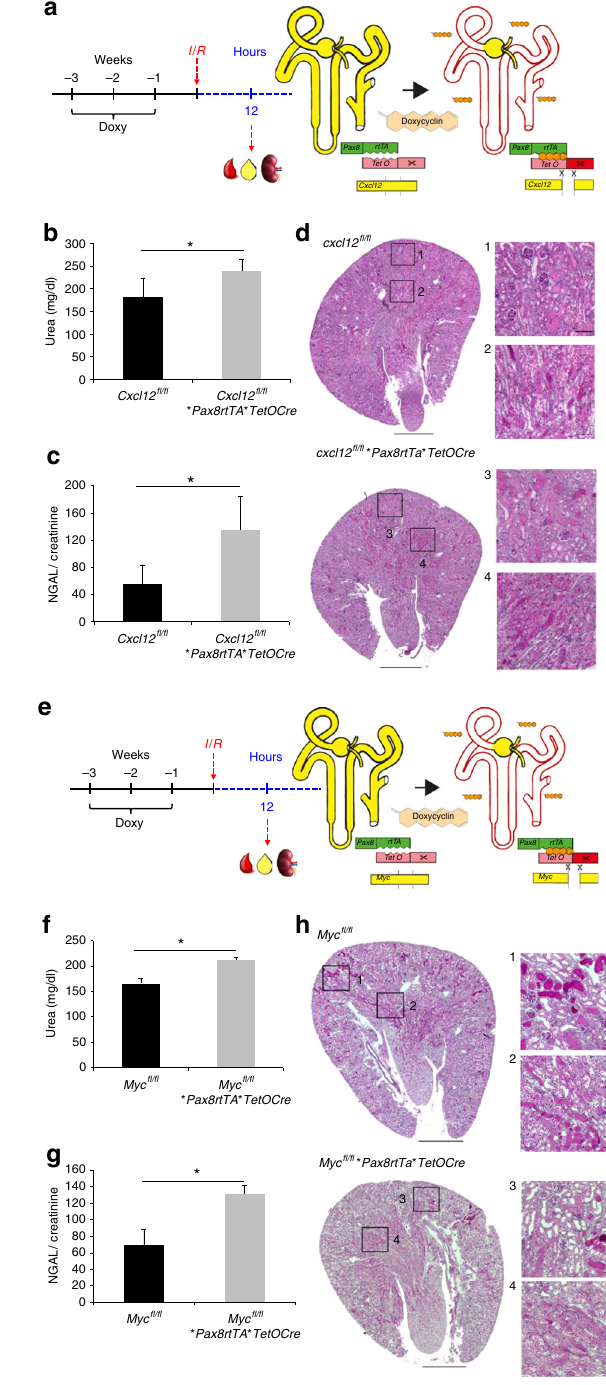
(Fig. 6f, g), while histological differences were not apparent between these two mouse strains (Fig. 6h, and Supplementary Fig. 14). speci fi c gene excision, RNA sequencing of kidneys removed from separation of KO and WT mice in the principal component analysis (Supplementary Fig. 15). Both KO kidneys displayed pro fi les (Supplementary Fig. 16 – 18, and Supplementary Data 1 – 4); this metabolic signature was re fl ected in the top 25 down-